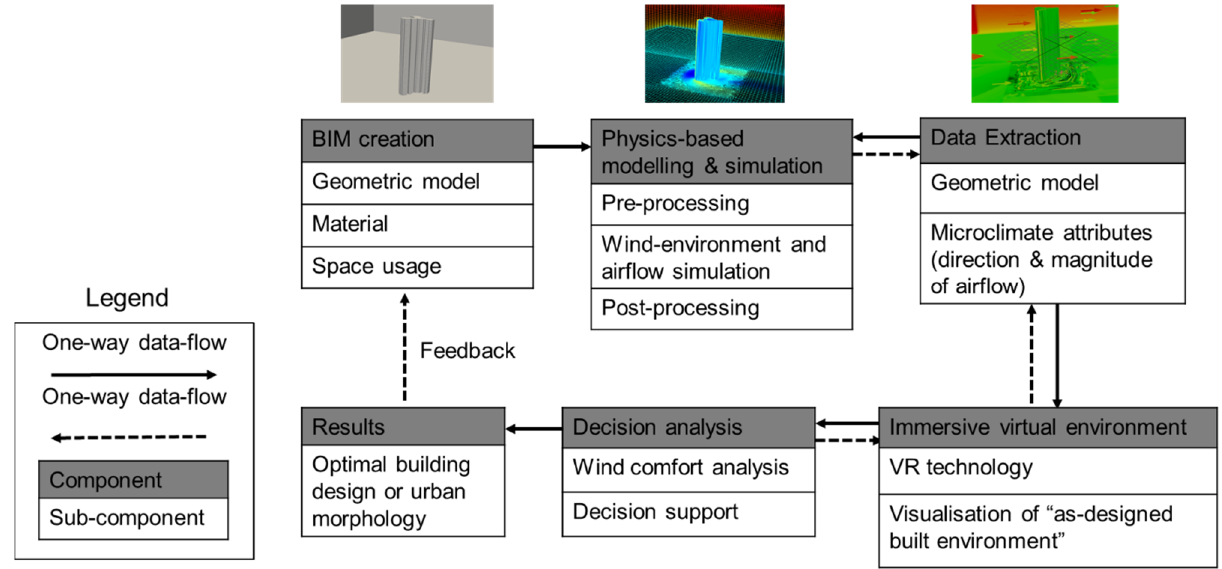
Figure 9. Process flow of the immersive VR visualization.